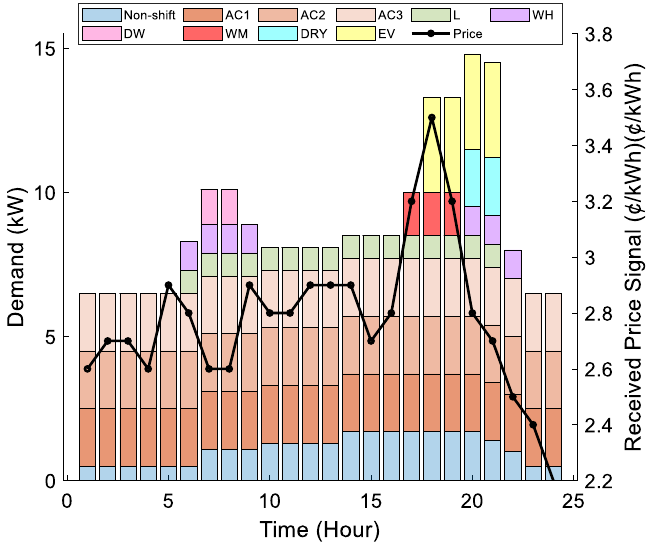
Figure 3. Aggregated energy consumption of all loads before DR (Base Case).